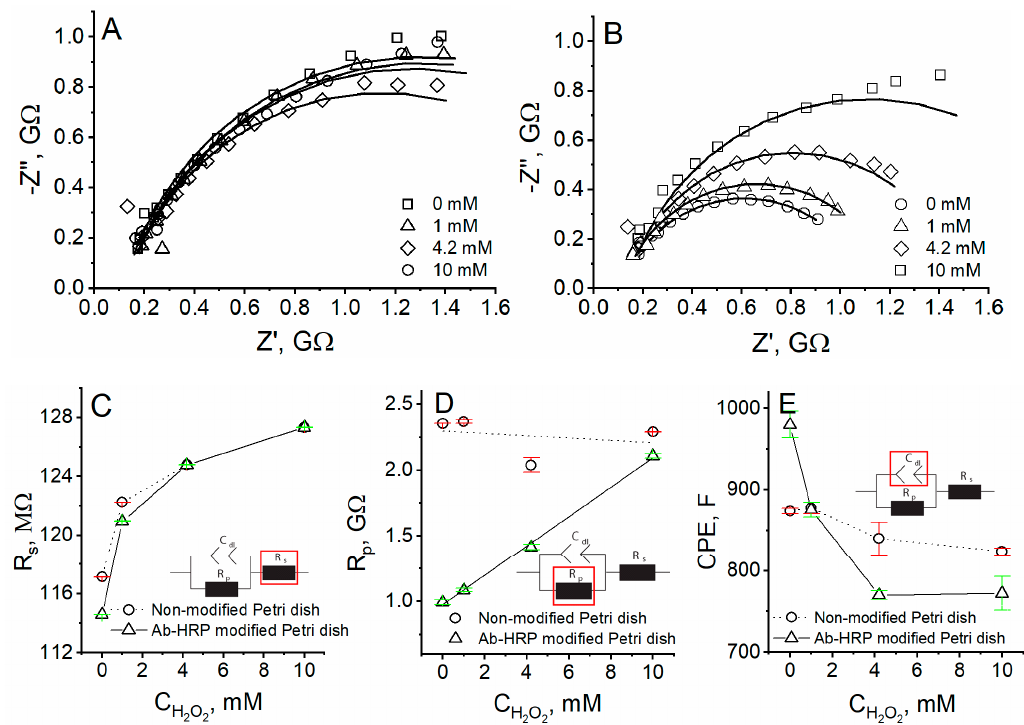
Figure 2. Nyquist plots of experiments performed at 2-µm distance from ( A ) unmodified Petri dish and ( B ) Ab-HRP- modified Petri dish in A-PBS with 1 mM K 3 [Fe(CN) 6 ]/K 4 [Fe(CN) 6 ] using different concentrations of H 2 O 2 ; dependence of ( C ) resistance of solution, ( D ) resistance of charge-transfer, ( E ) double-layer capacitance on H 2 O 2 concentration using unmodified and Ab-HRP-modified Petri dishes.